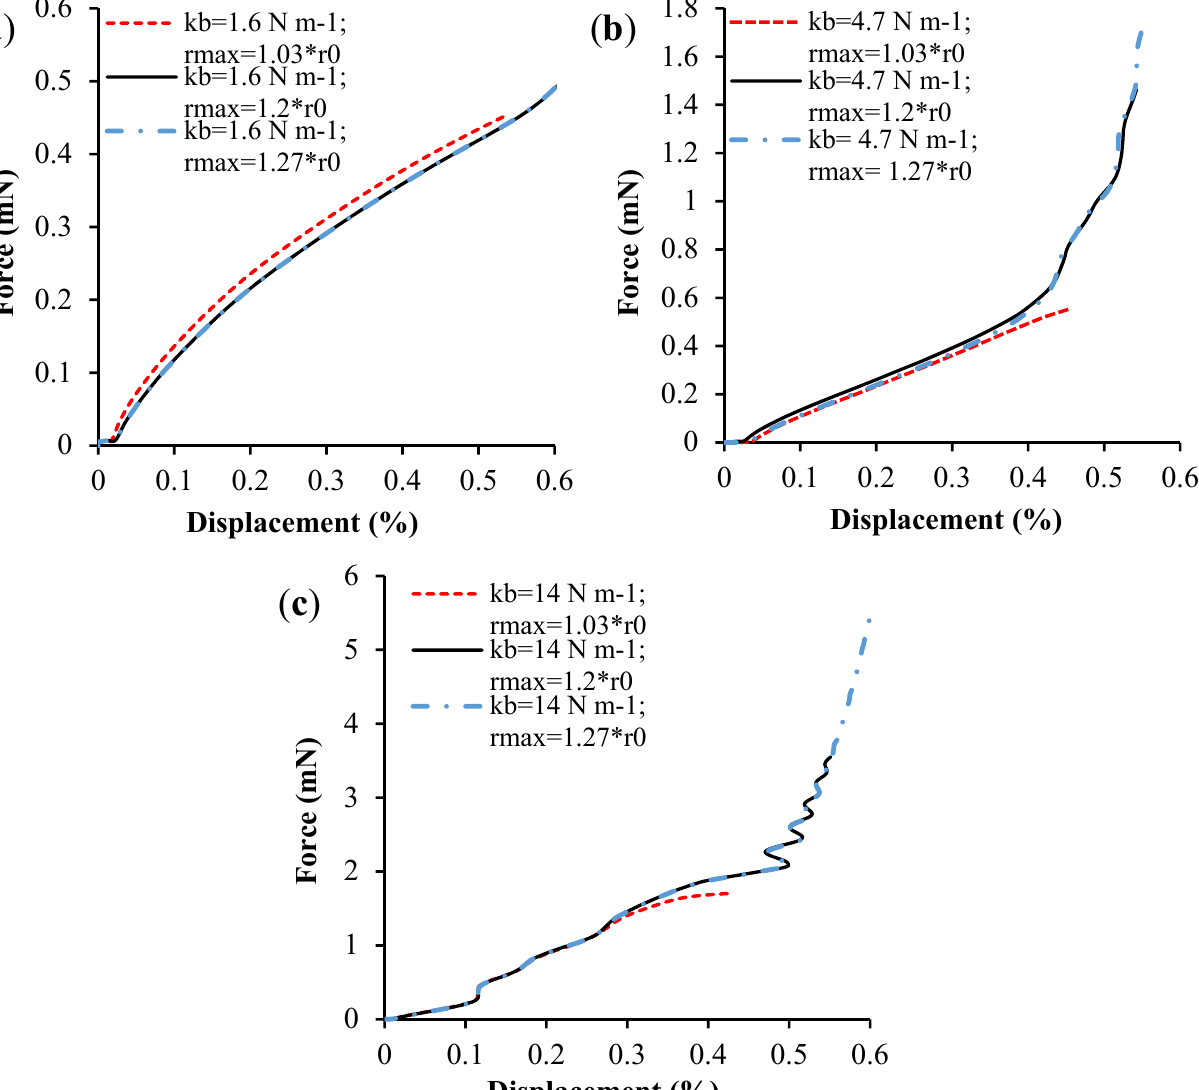
Figure 7. Simulated force–displacement curves for ( a ) k b = 1.6 N − 1 m and a range of r max values, ( b ) k b = 4.7 N − 1 m and different values of r max and ( c ) k b = 1.6 N − 1 m and different values of r max .